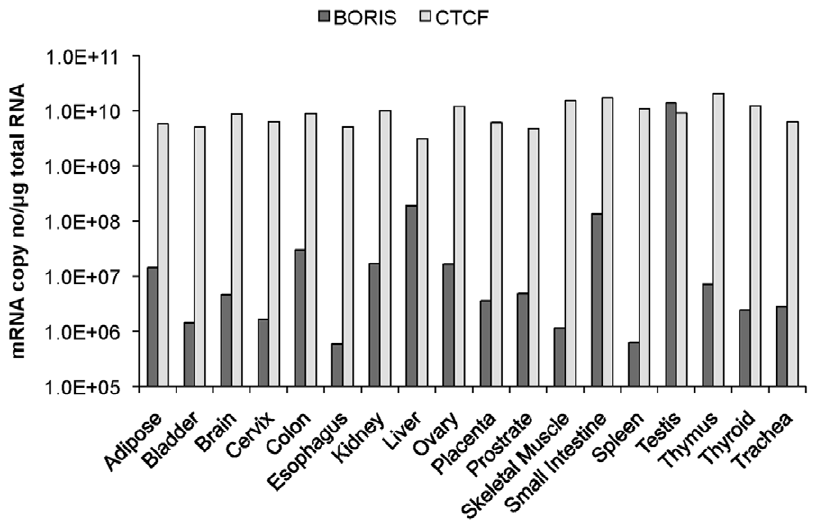
Figure 1. BORIS and CTCF expression in normal human tissues. BORIS transcript levels in normal human tissues (First choice H Human Total RNA Survey Panel, Ambion, UK). Error bars represent the standard deviation.